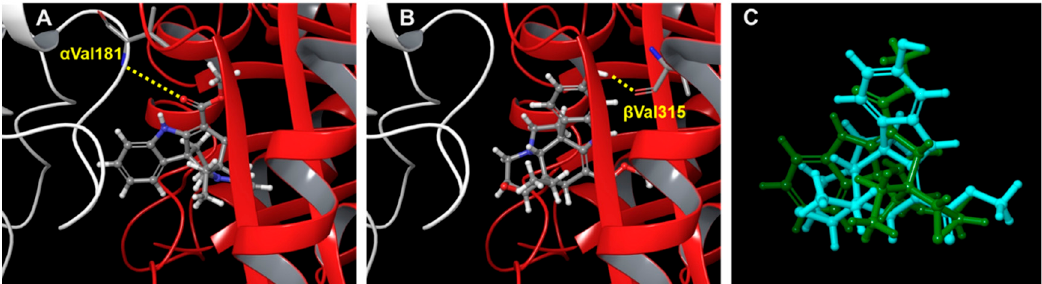
Figure 4. Predicted docking models for 5 and 7 binding in the CS. The crystal structures (PDB: 1SA0) of α - (white) and β -tubulin (red) are shown as ribbon diagrams. The distances calculated to be less than 5 Å between heavy atoms are represented by dashed lines. Docking models of compounds (gray skeleton with oxygen in red and nitrogen in blue) 5 ( A ) and 7 ( B ) in the CS are shown. Superimposition of docked compound 5 or 7 shows H-bonds with the side chain of α Val181 or β Val315, respectively. ( C ) Comparison of docking mode of 5 (green) with that of 7 (blue) in CS.